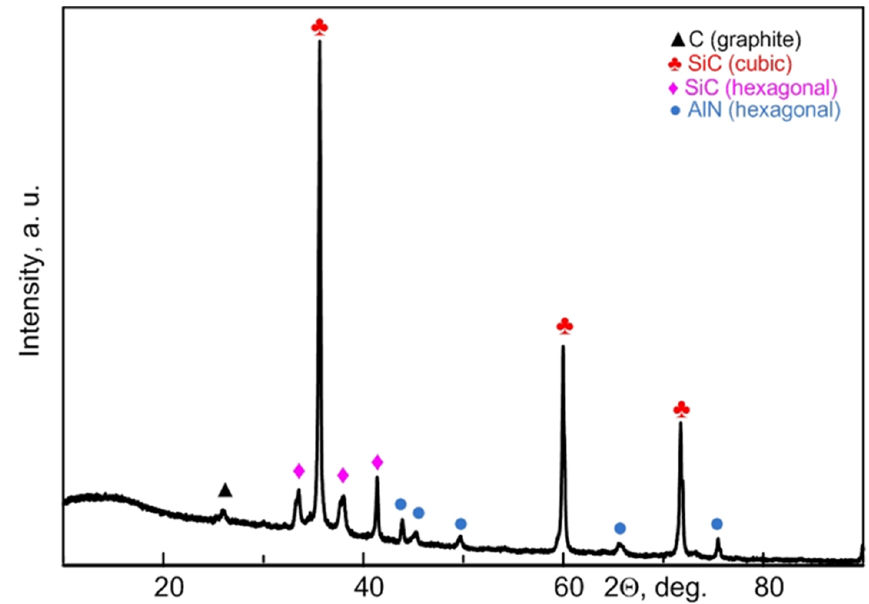
Figure 5. XRD pattern of silicon carbide-based micropowder obtained in the recommended mode (220 A, 25 s) and purified from excess carbon.